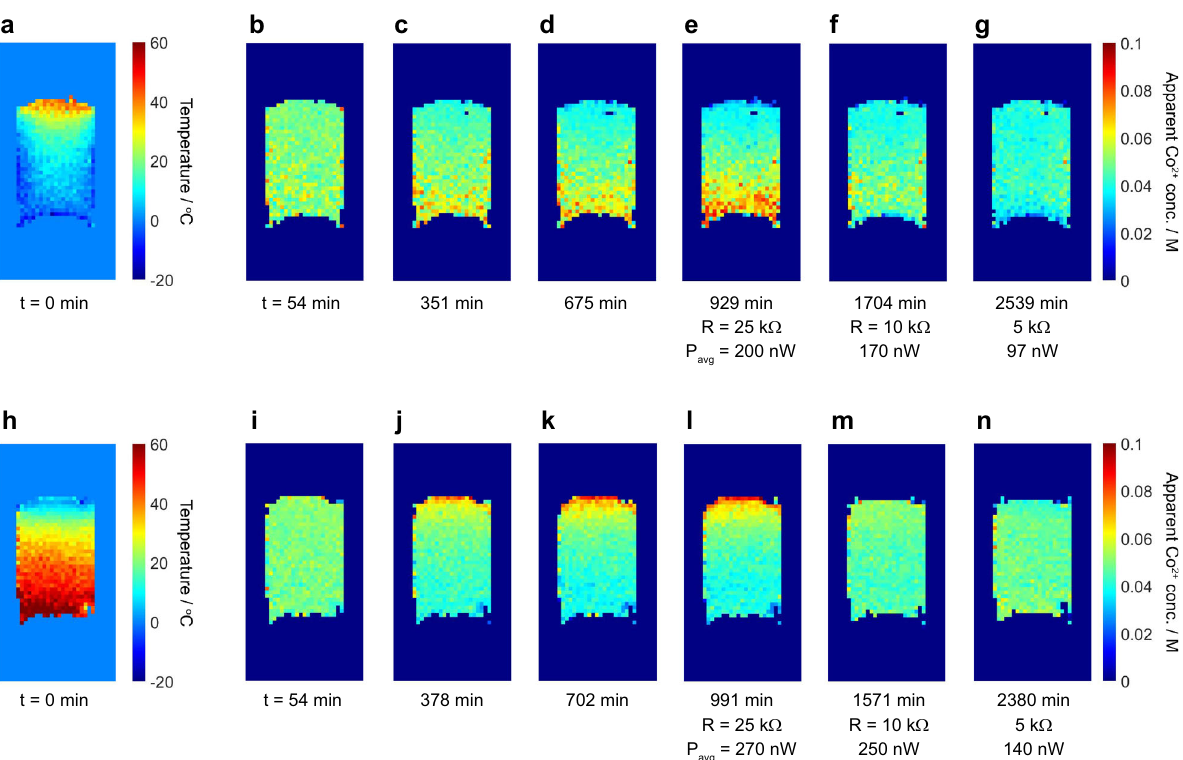
Fig. 7 Competing mass transfer effects in the horizontal electrode cells. Temperature and apparent Co 2 + concentration maps for the horizontal electrode cells in the hot-above-cold ( a – g ) and cold-above-hot ( h – n ) con fi gurations. In both cases, the initial connection to an external load resistance was made at t ≈ 700 min. Plots of cell current and voltage versus time for these experiments are provided in Supplementary Figs. 14 and